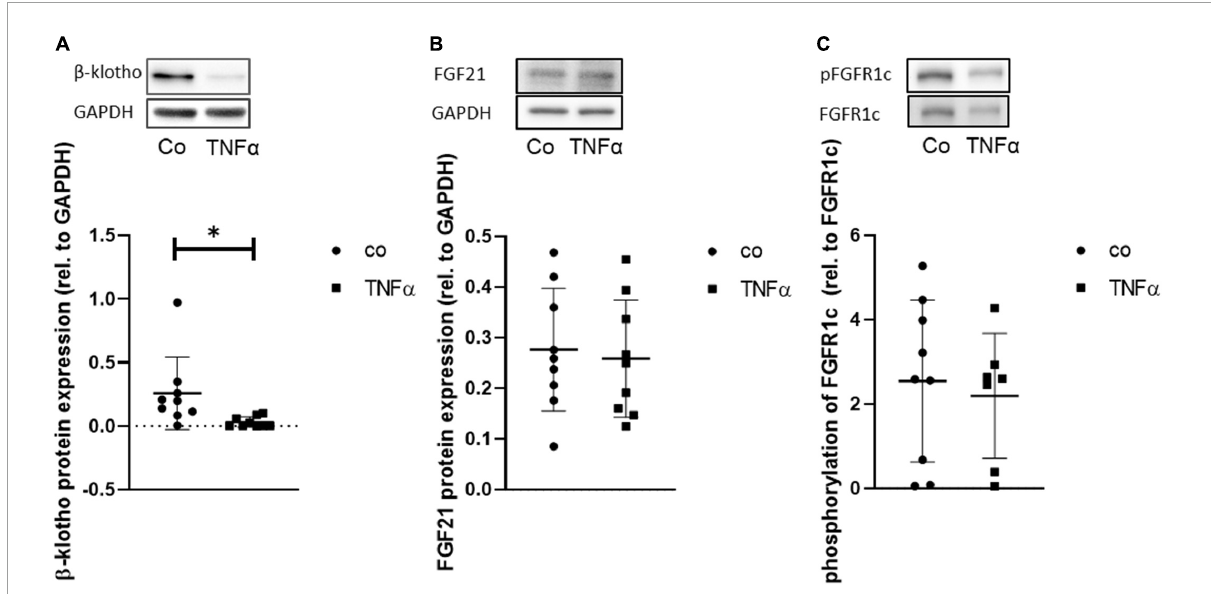
FIGURE7 Representative Western blot and quantitative analysis of protein expression of β -klotho (A) and of FGF21, (B) and phosphorylation of FGFR1c (C) in HepG2 cells upon incubation of TNF for 24 h. Signals were normalized to GAPDH or FGFR1c, respectively. Data are presented as mean ± SD; n = 9 independent experiments; unpaired Student’s t -test, ∗ p < 0.05 vs. control